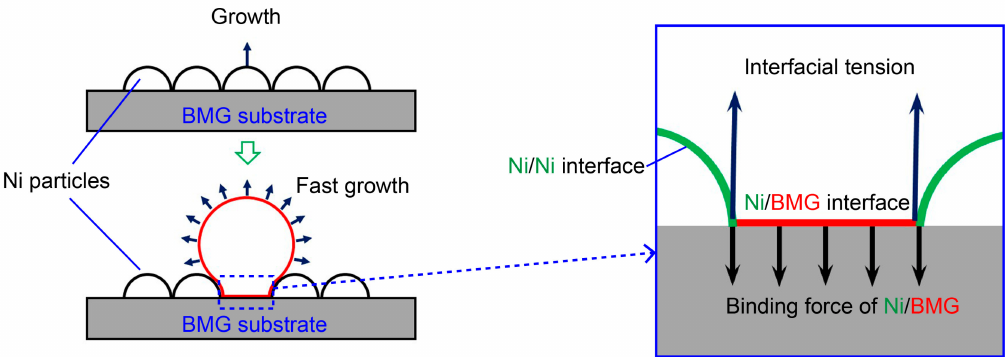
Figure 8. Schematic diagram showing the formation of tensile stress on the interface between the coating and the BMG substrate caused by the abnormal growth of nickel particles during electroless nickel